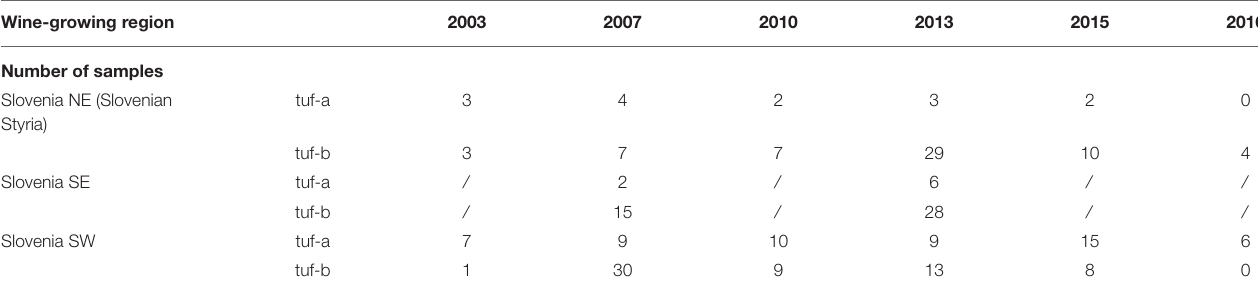
TABLE 2 | Restriction fragment (RFLP) patterns of TUFAY of samples from all Slovenian wine-growing regions. Wine-growing region 2003 2007 2010 2013 2015